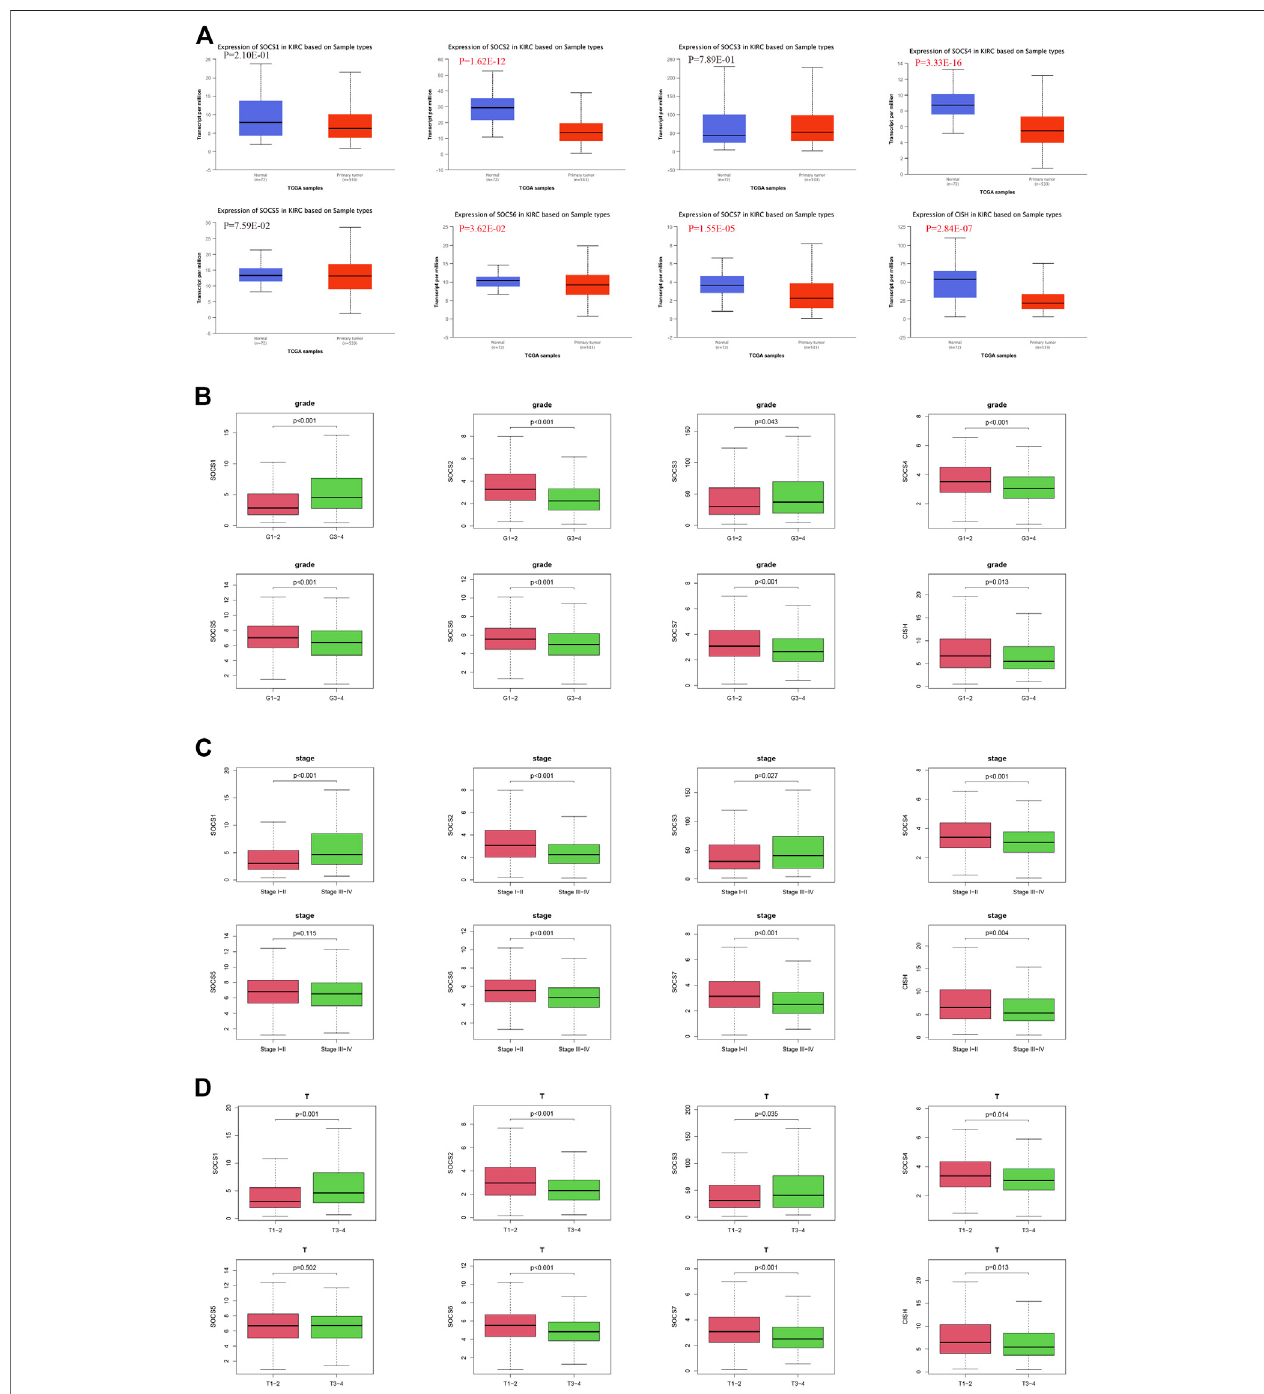
FIGURE 1 | Expression levels of SOCS family members in KIRC and correlation with different clinicopathological features. (A) Expression levels of SOCS family membersinKIRCweredeterminedbyUALCAN. (B) CorrelationbetweenexpressionlevelsofeachSOCSfamilymemberandhistologicalgrade. (C) Correlationbetween expression levels of SOCS family members and pathological stage. (D) Correlation between expression levels of SOCS family members and T stage.